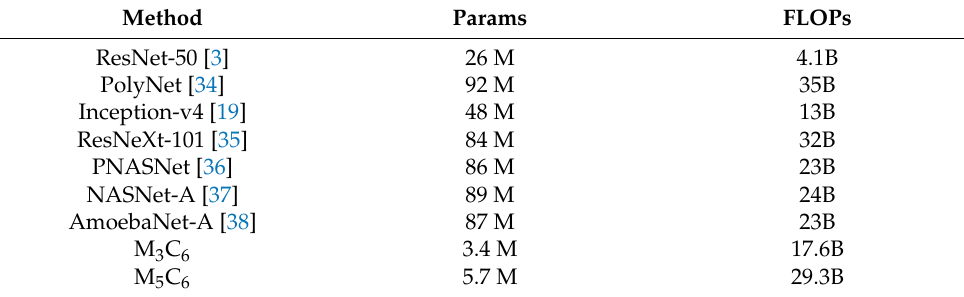
Table 1. Parameters and FLOPs of Model.